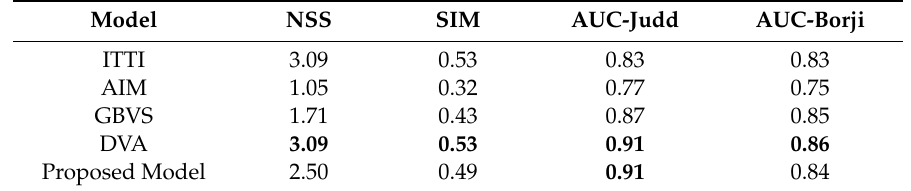
Table 4. Comparison of the quantitative scores of several models for the DUT-OMRON [31] dataset.